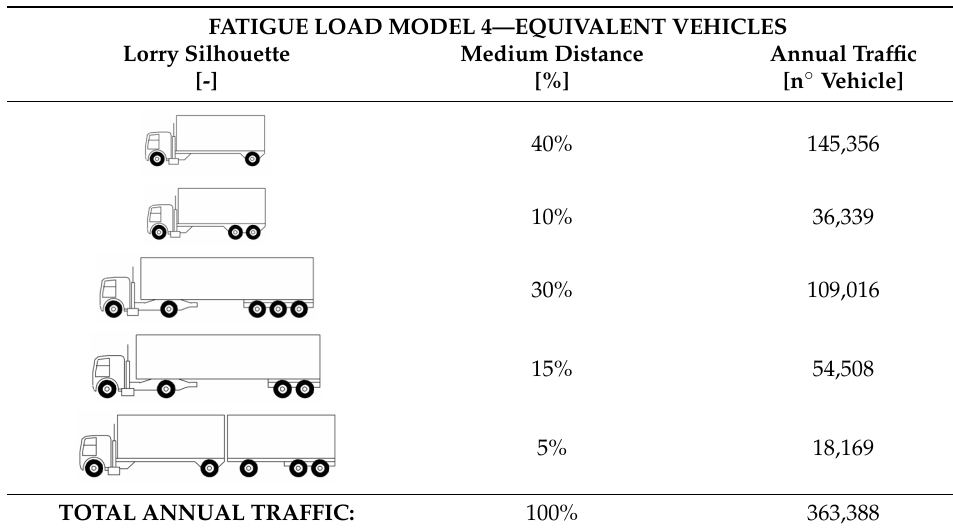
Table 3. Composition of annual heavy vehicle traffic according to the five truck templates of FLM4